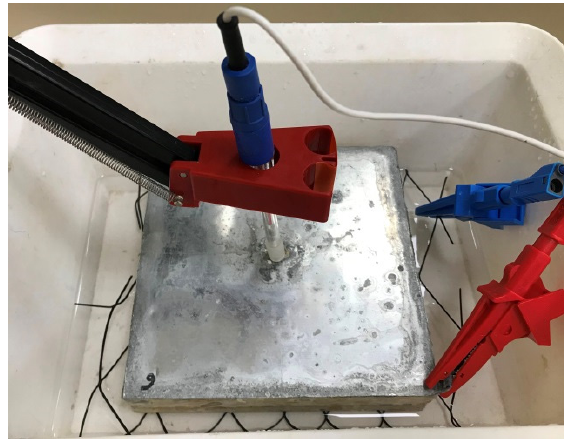
Figure 2. Photograph of the electrochemical cell. The titanium mesh, used as a counter electrode, was tank. The concrete specimen was saturated but not fully